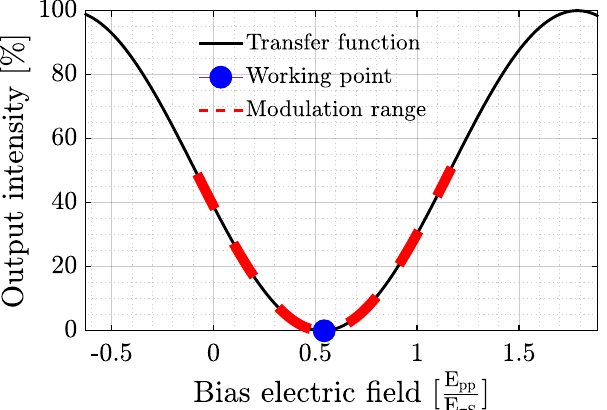
Figure 4. Range of modulation around the working point with no electric field incident on the second